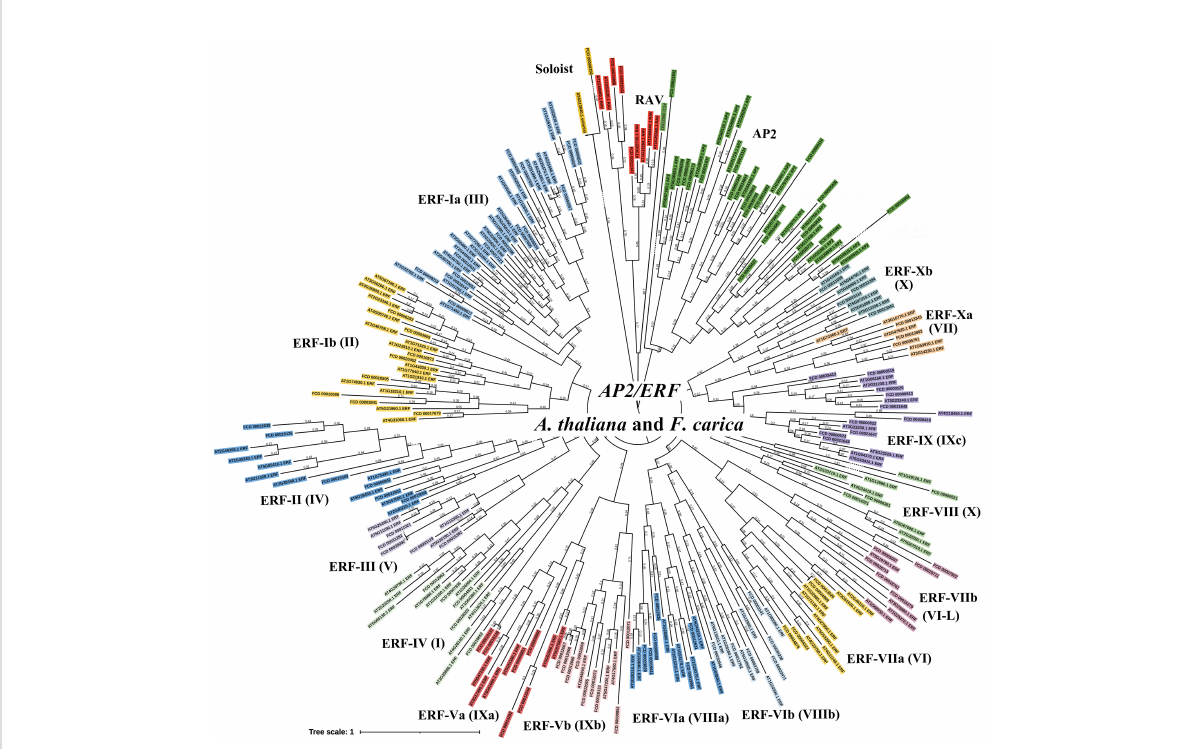
FIGURE 2 Phylogenetic tree showing the relationships between the 119 AP2/ERFs in F. carica and homologs in A. thaliana . There were 1000 bootstrap replicates.